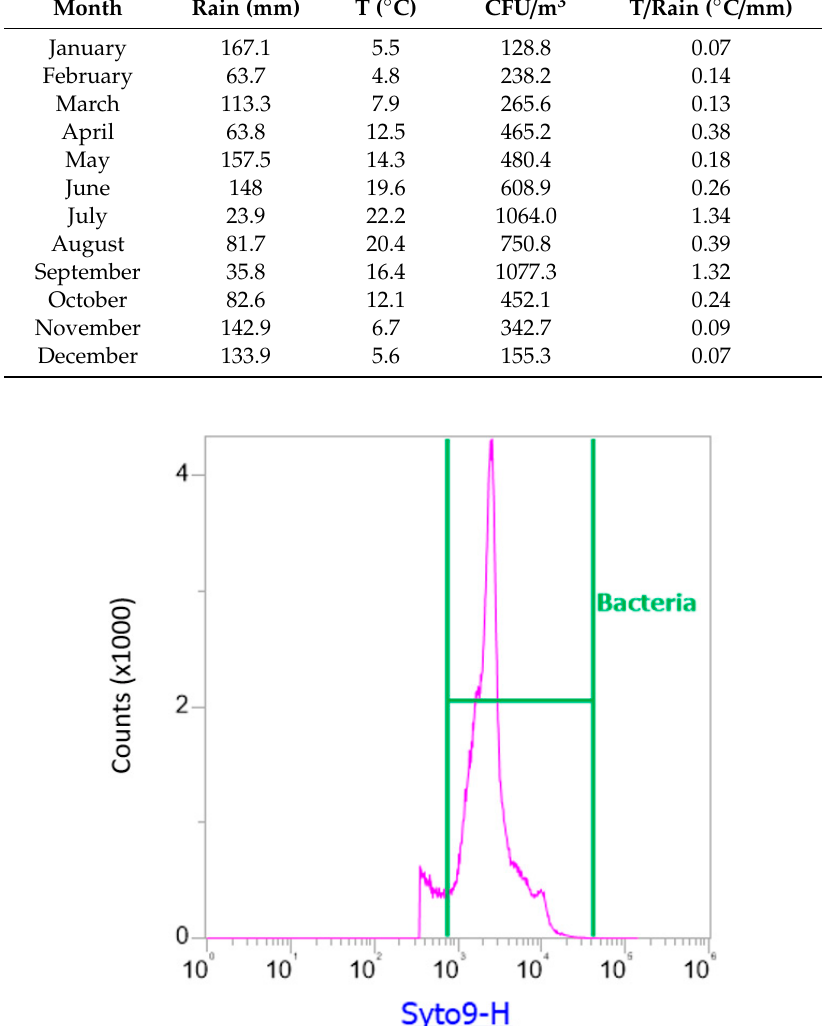
Figure A1. Determination of the bacteria detection zone R1 (green frame) in full size where Syto9-H is the range in the fluorescence signal.